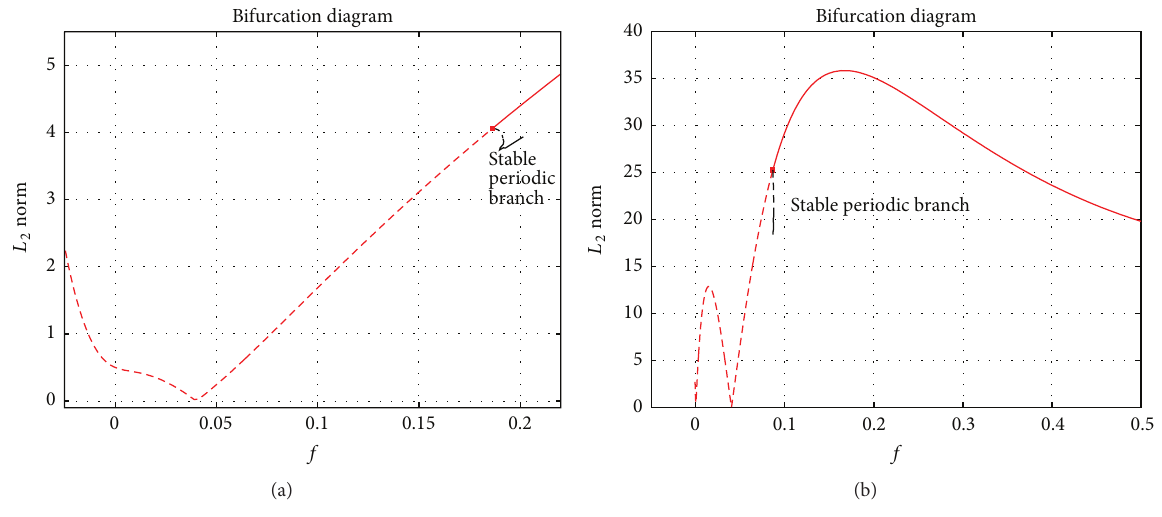
Figure 5: Case 4. (a) 𝑚 = 1 , (b) 𝑚 = 3